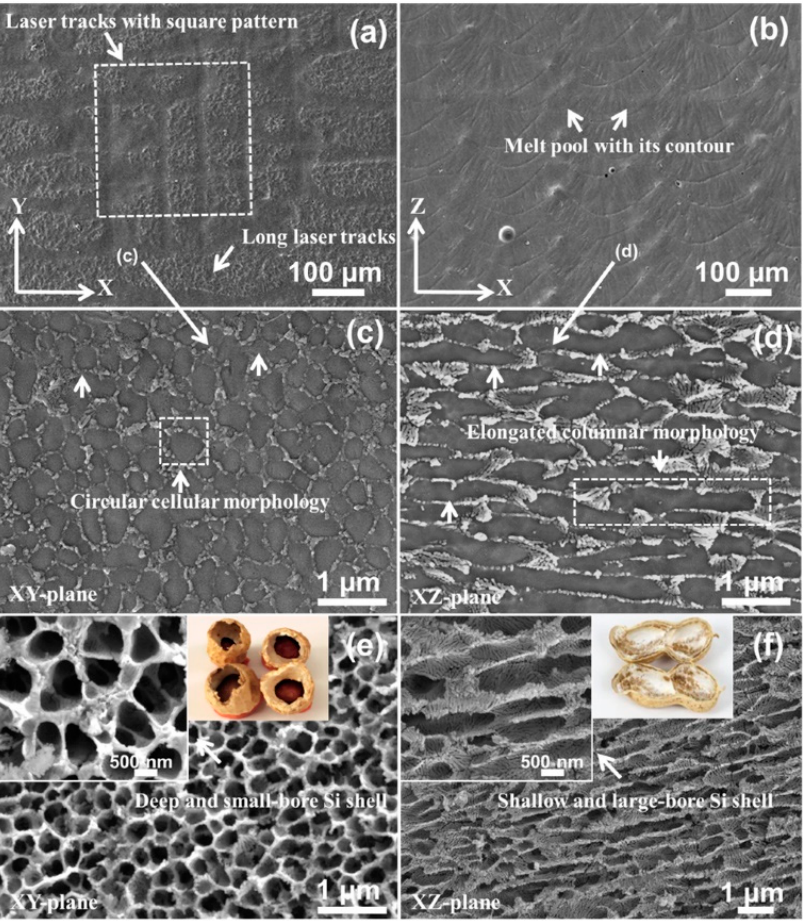
Figure 2. The microstructure of two different planes of SLM Al-12Si alloy: ( a ) polished XY plane; ( b ) polished XZ plane; ( c ) eutectic Si networks of XY plane; ( d ) eutectic Si networks of XZ plane; ( e ) the eutectic Si shells of XY plane; ( f ) the eutectic Si shells of XZ plane [68]. It is found that there are three distinct regions on both side of the SLM produced samples (XY-plane and XZ-plane); each region is composed of the cell-like structure with comparable size and number density. For the SLM AlSi10Mg alloy, the center of the melt pool consists of the fine cellular structure; the Al matrix is surrounded by the eutectic Si networks, which are woven by the nano-sized Si particles [34,46,79]. The area between the center and boundary of the melt pool is composed